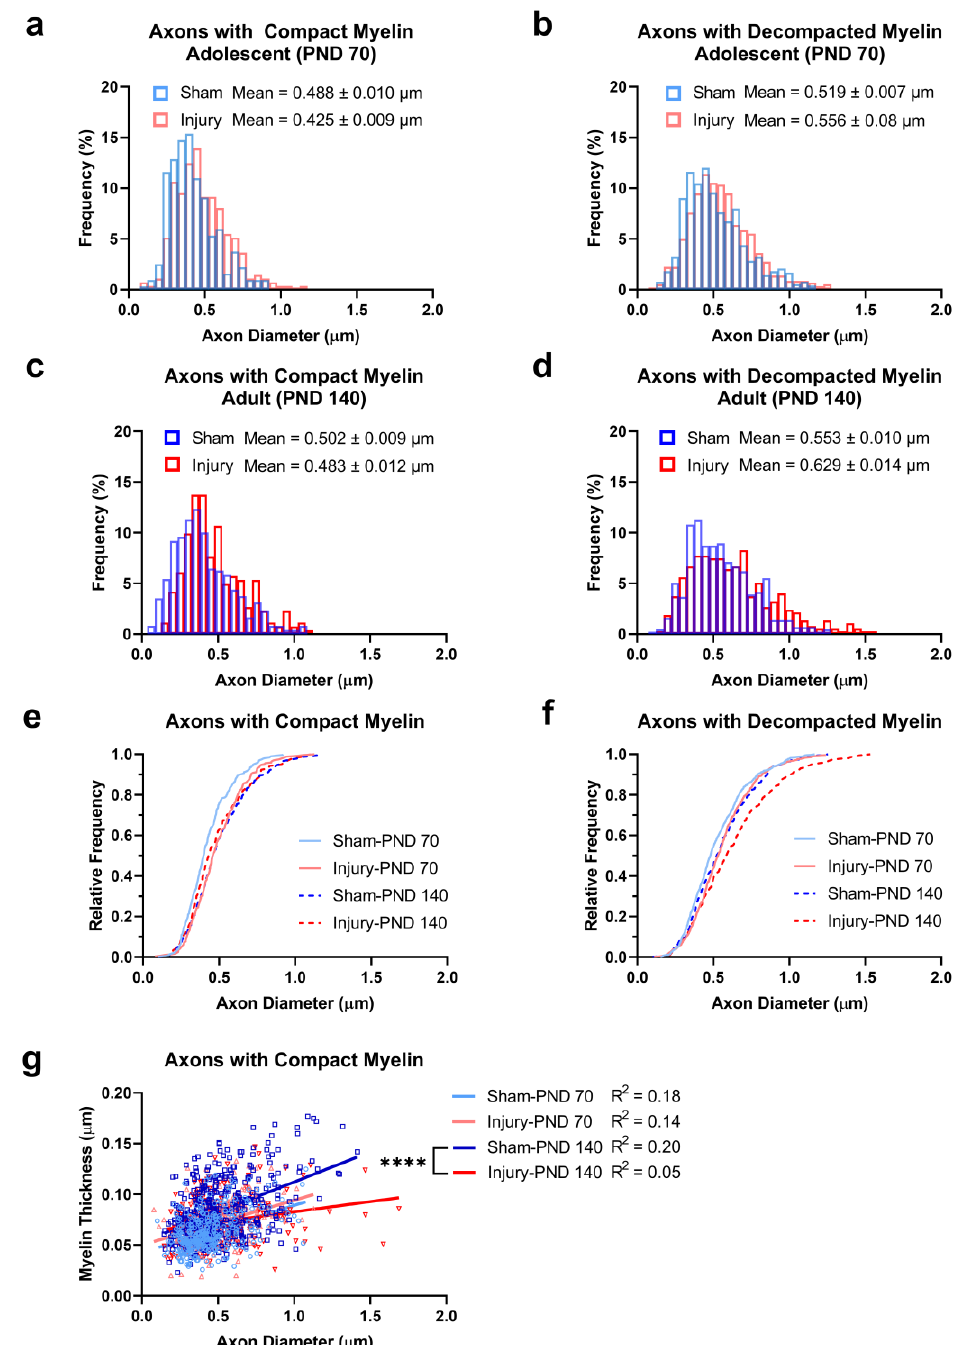
Figure 5. Population analyses of axon diameter and myelin thickness distributions. Overlaid histogram plots display the frequency distributions of all axons with compact myelin in injury- and sham-adolescent (PND 70) rats ( a ), and similarly for axons with decompacted myelin (representing all axons with 10–100% circumference affected by decompaction) in adolescent (PND 70) rats ( b ). Overlaid histogram plots displayed the frequency distributions of all axons with compact myelin in injury- and sham-adult (PND 140) rats ( c ), and similarly for all axons with decompacted myelin in adult (PND 140) rats ( d ). Cumulative frequency plots illustrate the distribution of axon diameters in all axons with compact myelin ( e ) and all axons with decompacted myelin ( f ) at the population level. A scatter plot including all data illustrated the relationship between myelin thickness and axon diameter in axons with compact myelin with overlaid lines of best fit ( g ). **** indicate slope comparison p < 0.0001.